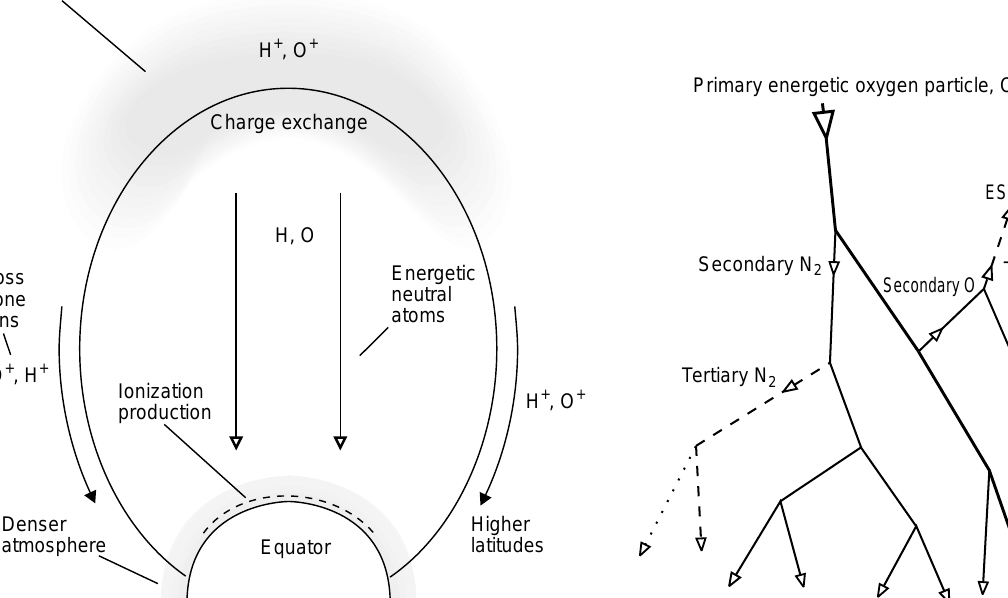
Fig. 4. Energetic oxygen particle trajectory in the upper